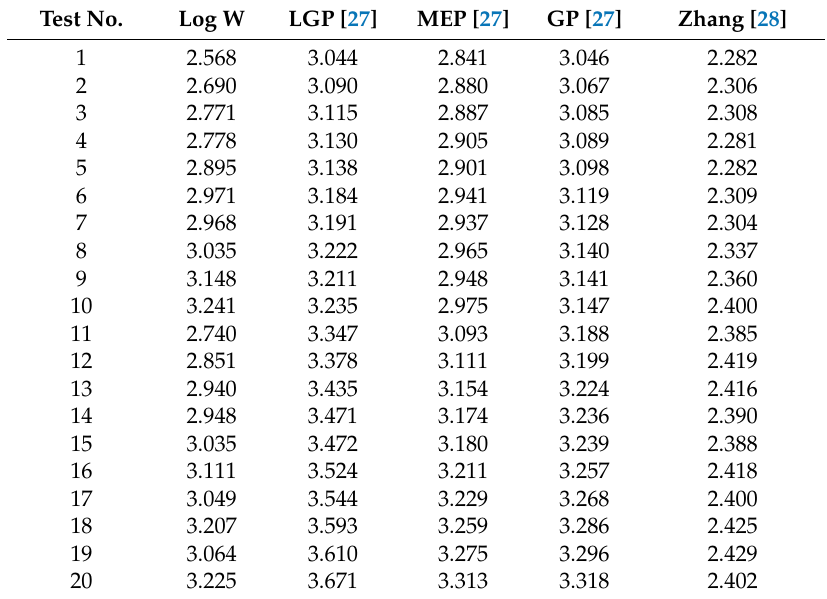
Table 13. Predicted results of four available models and measured results of 20 samples. Test